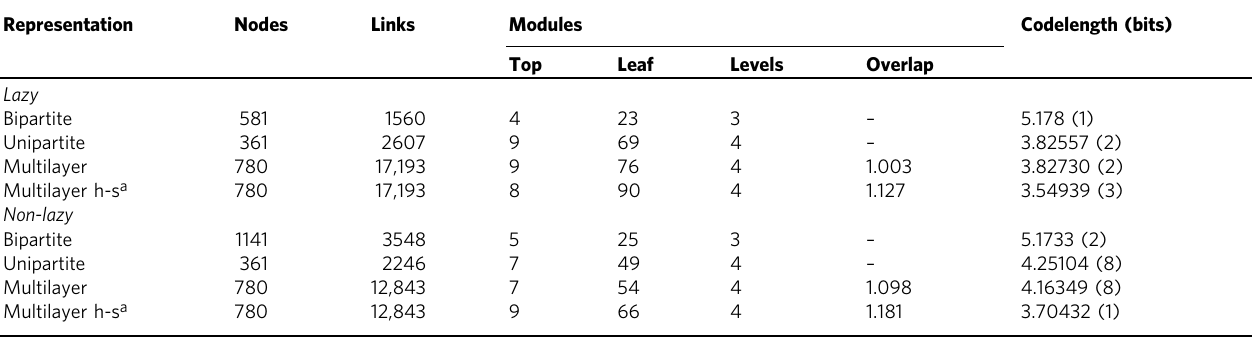
Table 2 Optimised fl ow-based multilevel communities of the collaboration hypergraph represented with different networks.